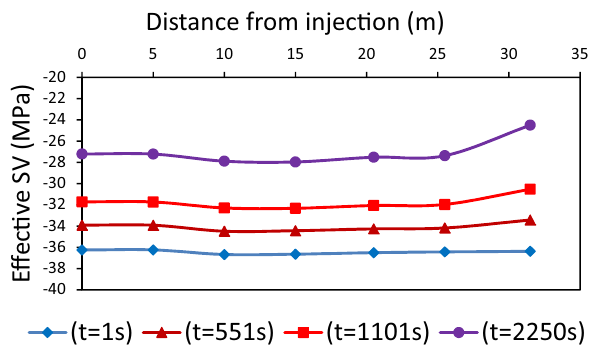
Fig. 13 Case 2 ( k = 45.9 mD): Effective vertical stress versus distance along SRV height from the injection port at different injection times